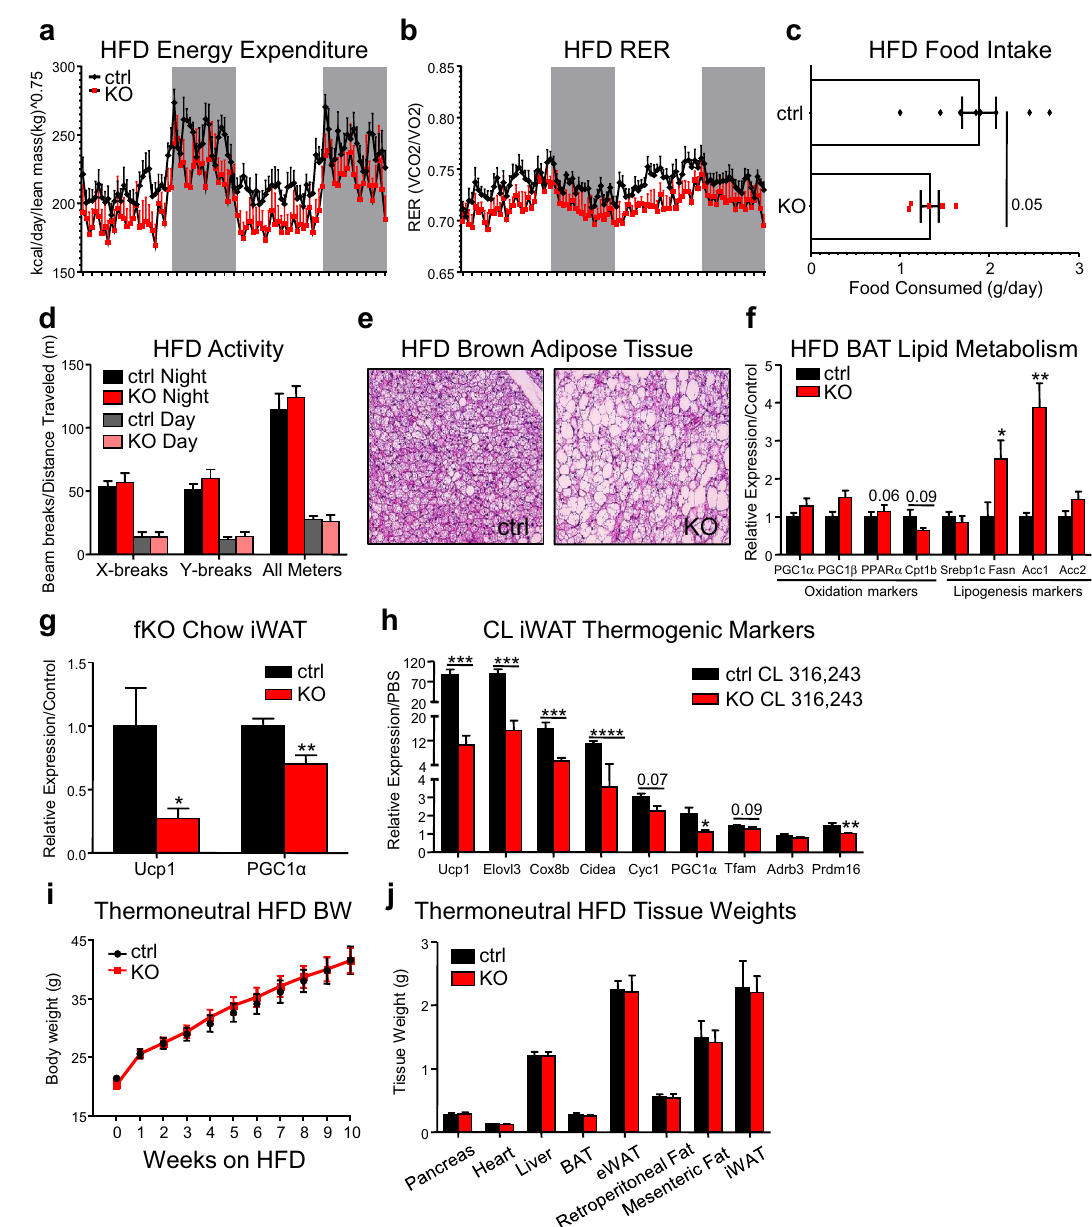
Figure 4. CREB3L3 fKO promotes weight gain by reducing energy expenditure and shifting brown fat lipid metabolism. ( a ) Energy expenditure and ( b ) respiratory exchange ratios (RER) of control and fKO mice fed high-fat diet (n = 6–8 mice per group). Energy expenditure was normalized to the animal’s lean mass. The curves for both measurements were analyzed using two-way ANOVA. P values for the column factor (genotype) for the energy expenditure and the RER were both < 0.0001. ( c ) Average daily consumption of high-fat diet while mice were in metabolic cages (n = 5–8 mice per group). ( d ) Activity measurements of control and fKO mice fed high-fat diet. Data presented as x- and y-axis beam breaks and total movement per day following acclimation period (n = 6–8 mice per group). ( e ) Representative images of H&E-stained brown adipose tissue sections following high-fat feeding. ( f ) Quantitative PCR for markers of fatty acid oxidation and lipogenesis in control and fKO brown adipose tissue following high-fat feeding (n = 5 mice per group). Expression was normalized to TBP and presented as fold change over controls. ( g ) Quantitative PCR for UCP1 and PGC1a in control and fKO inguinal adipose tissue in mice fed a chow diet (n = 5–6 mice per group). Target gene expression was normalized to TBP and presented as fold change over controls. ( h ) Quantitative PCR for markers of thermogenesis and adipocyte browning in iWAT from lean control and fKO mice following 10-day treatment with CL316,243 (n = 6 mice per group). Target gene expression was normalized to TBP and presented as fold change over the mean relative expression from the PBS-injected group for each respective genotype. ( i ) Body weight measurements for control and fKO mice consuming high-fat diet while housed at thermoneutrality for 10 wks (n = 7–9 mice per group). ( j ) Tissue weight measurements for control and fKO mice after consuming high-fat diet while housed at thermoneutrality for 10 wks (n = 7–9 mice per group). Data presented as mean ± SEM with sample sizes listed above. The difference in means was analyzed using Student’s t-test where *P < 0.05 and **P < 0.01, ***P < 0.001, and ****P <